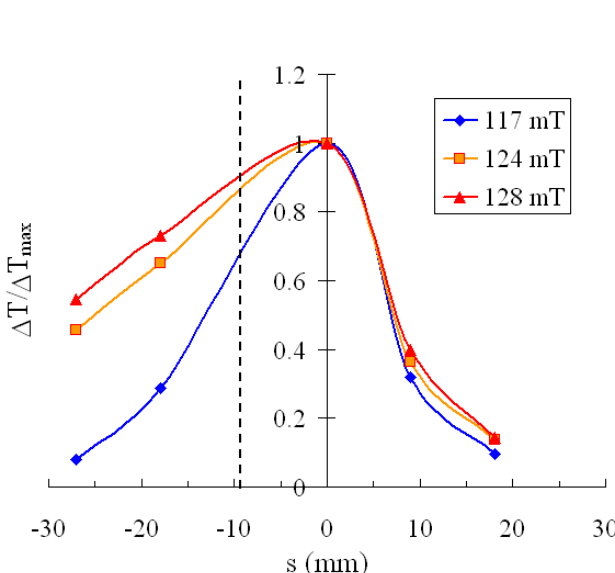
FIG. 21. (Color) Normalized (cid:2) T spatial distribution for a hot spot at s (cid:6) 0 for increasing values of B line represents the location of the equator